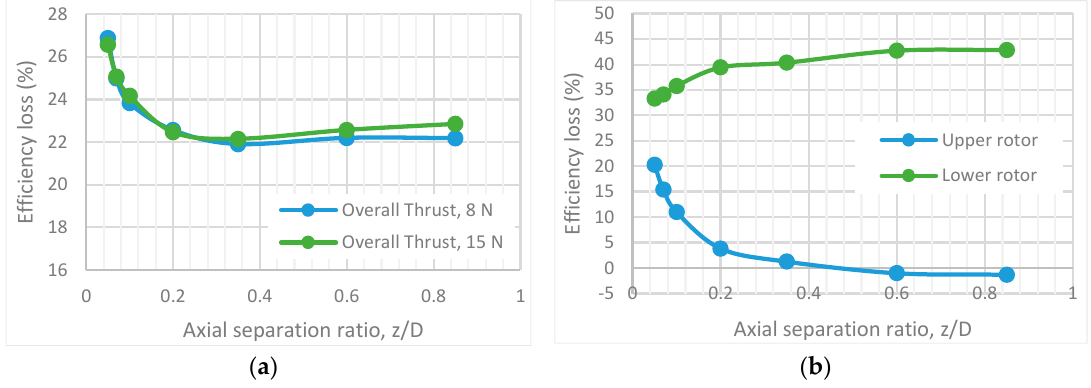
Figure 15. Co-axial propulsion system efficiency losses at various z / D ratios. ( a ) Overall co-axial system efficiency losses ( Q u + Q l = 0); ( b ) Individual rotor efficiency losses when operated in a co-axial setup ( Q u + Q l = 0 ) ; overall thrust, 8 N.